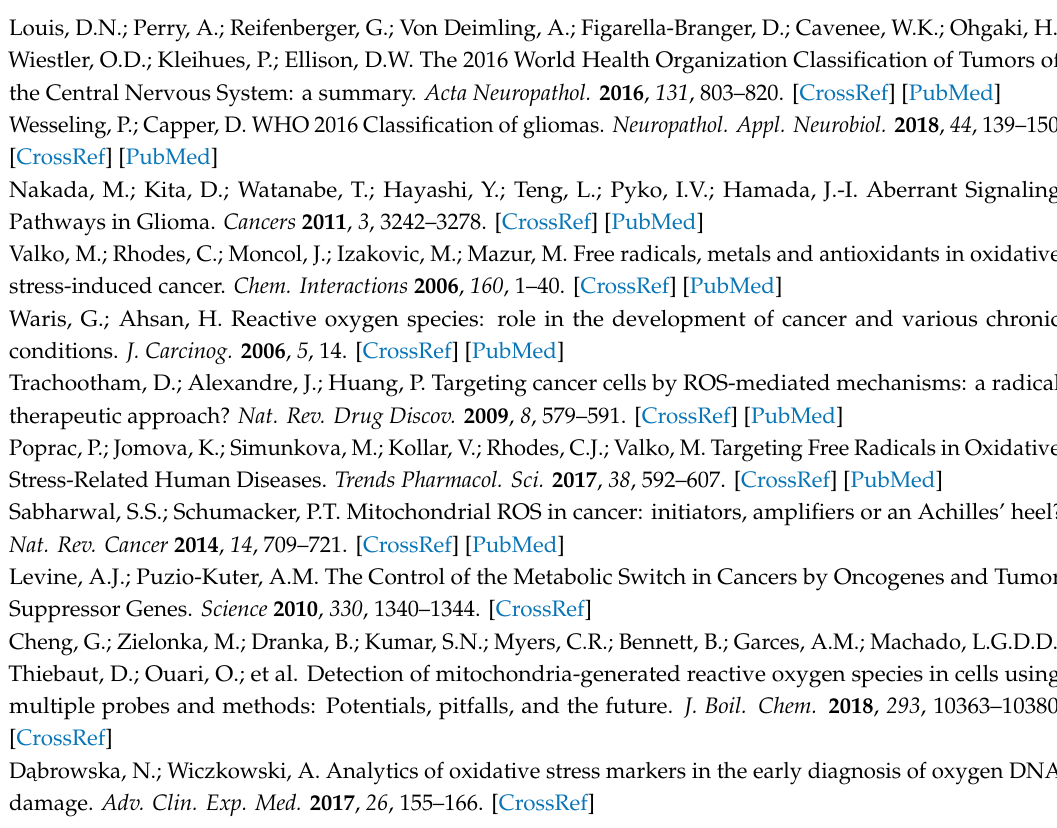
Table S1. The characteristics of 28 patients for whom the contents of m 5 C (post labeling method) and 8-oxo-dG (electrochemical detector) in DNA from tumor tissue were analyzed, as well as patients’ clinical characteristics. Table S2. The characteristics of 8 patients with WHO III and IV brain gliomas for whom the contents of m 5 C (post labeling method) and 8-oxo-dG (electrochemical detector) in DNA from peripheral blood samples were analyzed, as well as patients’ clinical characteristics. Table S3. The characteristics of 34 healthy individuals comprising the control group for whom the contents of m 5 C (postlabeling method) in DNA from peripheral blood samples was